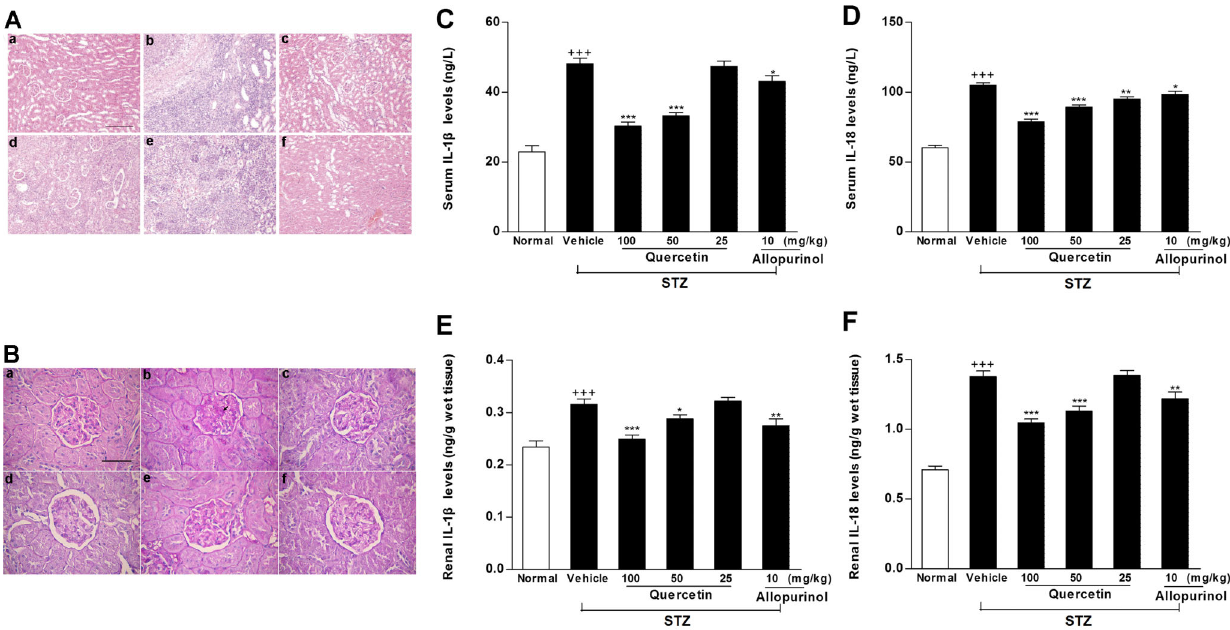
Figure 9. Quercetin and allopurinol attenuate inflammation in streptozotocin (STZ)-treated rats. HE stain (A) analyses showed inflammatory cell infiltration and PAS-D stain (B) analyses showed kidney structures in different groups of rats. Normal control (a), STZ alone (b), STZ plus 100 mg/kg quercetin (c), STZ plus 50 mg/kg quercetin (d), STZ plus 25 mg/kg quercetin (e) and STZ plus 10 mg/kg allopurinol (f); Bar=50 m m in Fig. 9Aa and Bar=15 m m in Fig. 9Ba. Biochemical analyses showed serum and kidney levels of IL-1 b (C, E) and IL-18 (D, F) at 7 weeks after STZ injection in different groups of rats as indicated. The data are expressed as the means 6 SEM (n=8). +++ P , 0.001 versus normal control; * P , 0.05, ** P , 0.01, *** P , 0.001 versus STZ control.